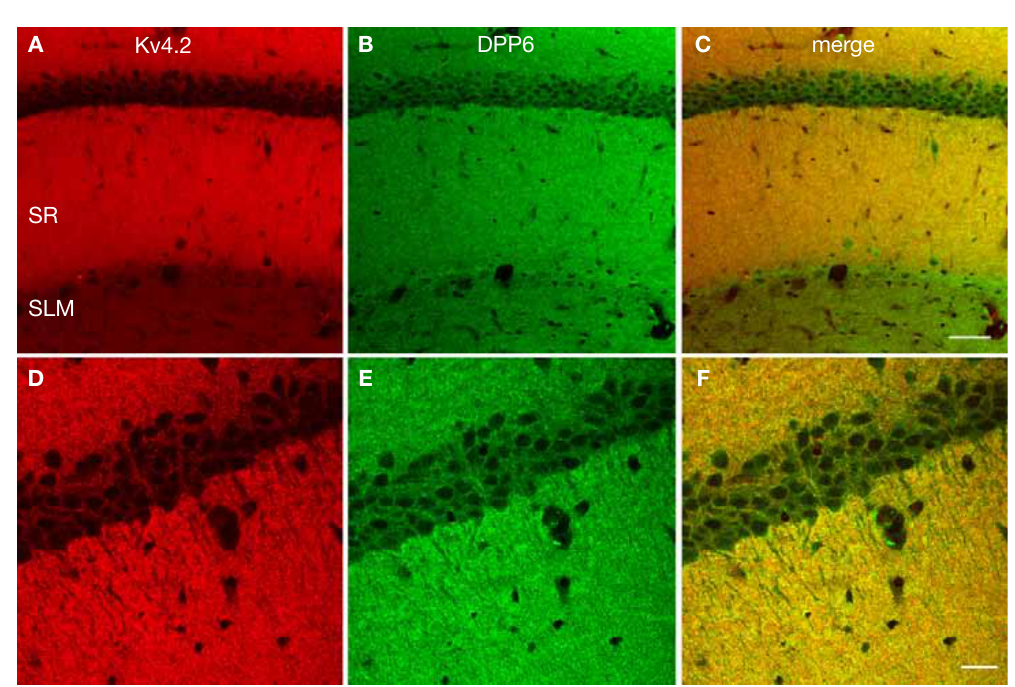
Figure 6 | Enrichment of Kv4.2 and DPP6 in CA1 pyramidal cell dendrites. Confocal image of the CA1 fi eld of the hippocampus in mouse double immunos- tained for Kv4.2 ( A , pseudocolored red) and DPP6 ( B , pseudocolored green) and the overlay of the two channels (C) . Strong staining of the stratum